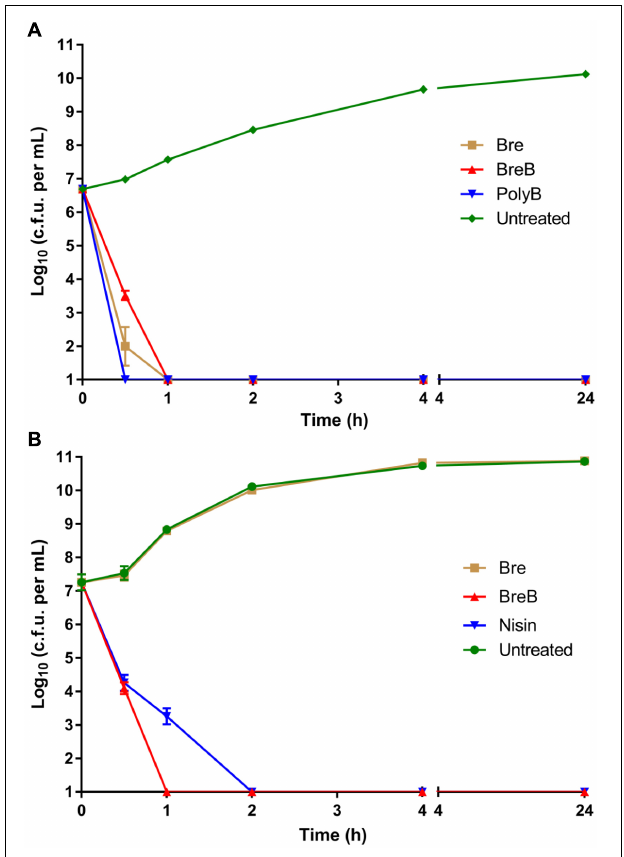
FIGURE 2 | BrevicidineB acts as a bactericidal antibiotic against both Gram-negative and Gram-positive pathogenic bacteria. (A) time killing curve of brevicidines (10 × MIC) against Escherichia coli . Each experiment was performed in triplicate. (B) time killing curve of brevicidines (10 × MIC) against Staphylococcus aureus (MRSA). Each experiment was performed in